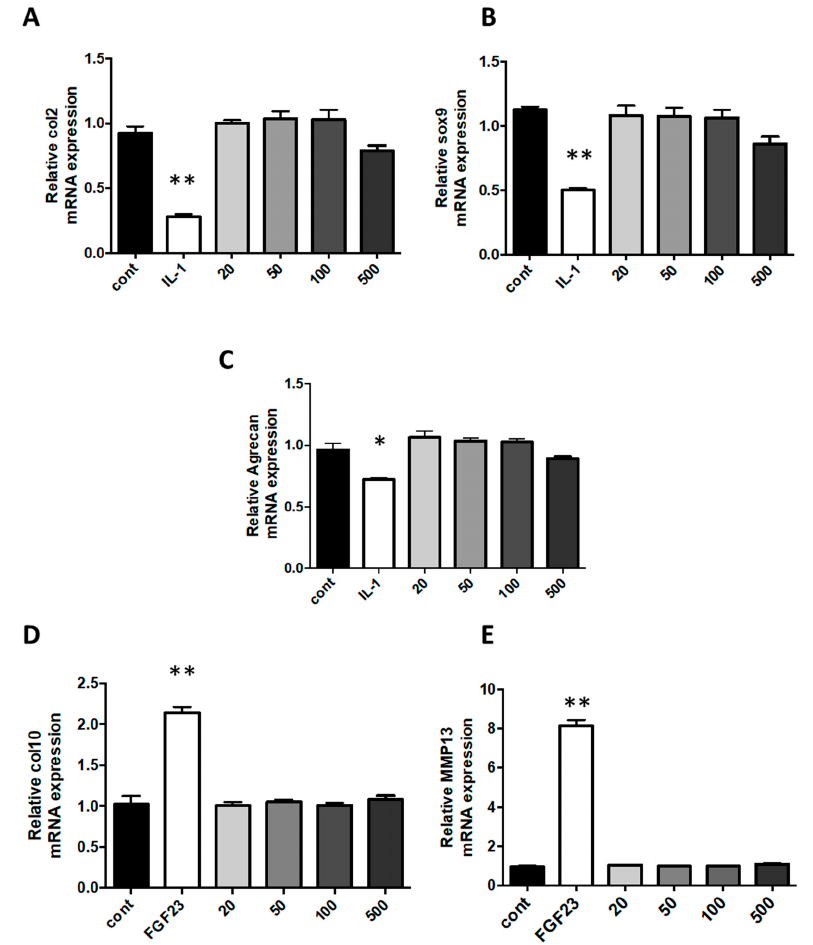
Figure 5. Effect of nanoliposomes exposition on the expression of chondrocytes specific markers. Rat chondrocytes were exposed to increasing concentrations of nanoliposomes (20, 50, 100, and 500 µ g / mL) for 24 h or with 10 ng / mL rhIL-1 β (A–C) or 100 ng / mL rhFGF23 (D, E). Total RNA was extracted then reverse transcribed into cDNA and analyzed by RT-PCR. The relative abundance of type II collagen ( A ), Sox-9 ( B ), aggrecan ( C ), type X collagen ( D ), and MMP13 ( E ) mRNAs were normalized to RP29 mRNA. The comparison was made by using the ∆∆ Ct method with the fold value of reference = 1. The results shown are mean ± SD of at least four individual experiments. * p < 0.01 and ** p < 0.001 compared to control for each time